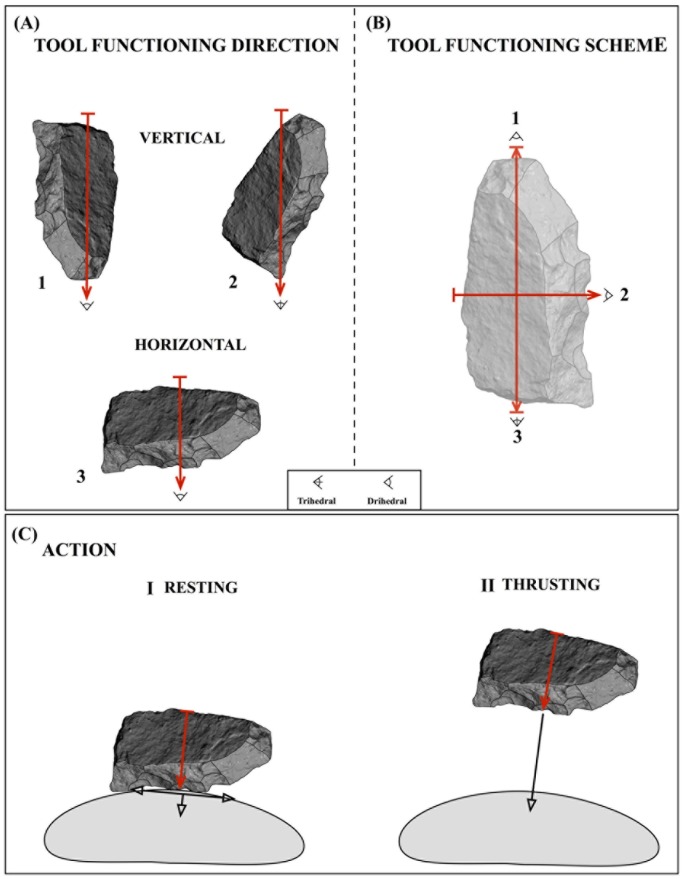
Tool functioning.(A) Tool functioning direction (TFD): 1. TFD: Vertical; Functional axis: Length axis (red arrow); Working edge location: Distal; 2. TFD: Vertical; Functional axis: Length axis (red arrow); Working edge location: Proximal; 3. TFD: Horizontal; Functional axis: Width axis (red arrow); Working edge location: Lateral. (B) Tool functioning scheme: Functioning axis direction (red arrows), working edge location (proximal: 1; distal: 2; lateral: 3), and geometry (dihedral: 1/3; trihedral: 2. (C) Action: resting (I) and thrusting (II) (black arrows indicate the direction of the push and pull forces exerted on the matter to transform), note that both actions are performed along the width axis/horizontal TFD (red arrow).